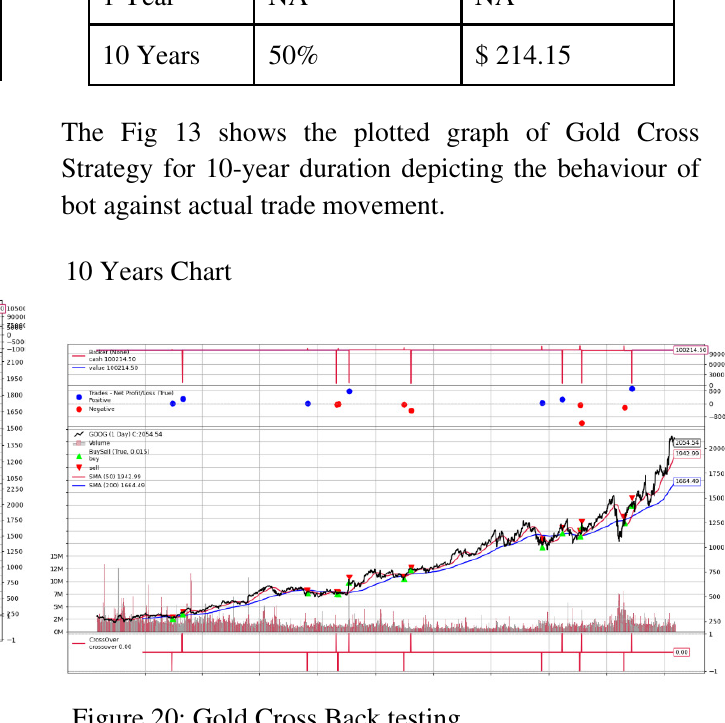
Figure 20: Gold Cross Back